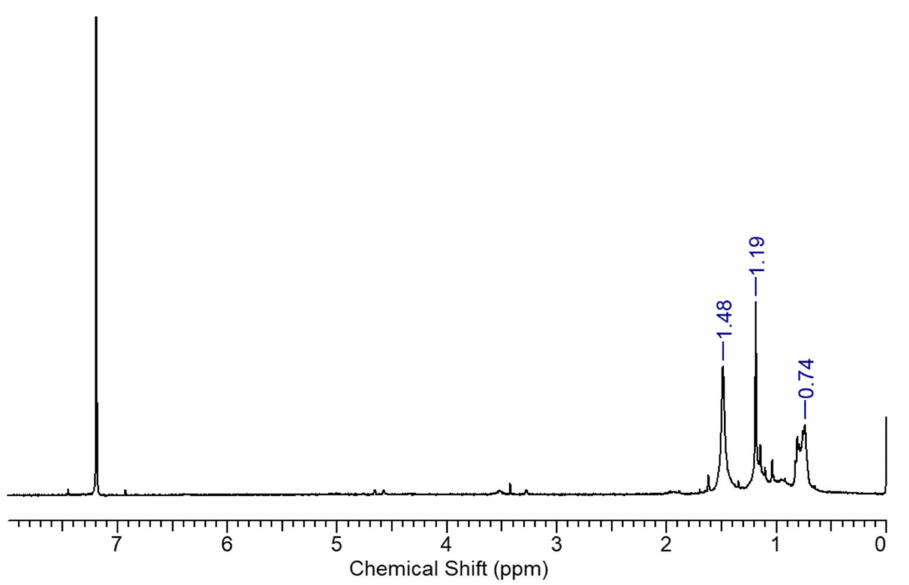
Figure 2. 400 MHz 1 H NMR spectrum of the polypropylene, produced via cyclodextrin (CD)-assisted aqueous free radical polymerization, in